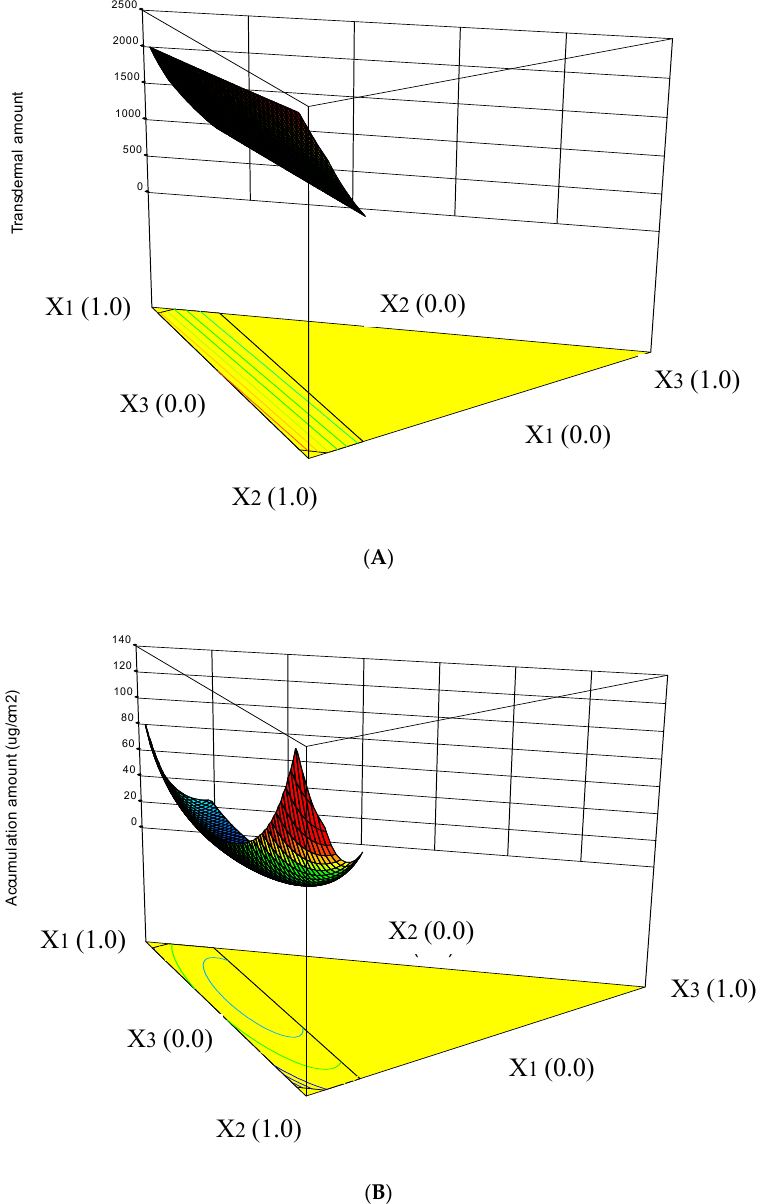
Figure 2. Three dimensional response surface diagrams for the influence of formulation variables on the transdermal amount ( A ) and accumulation amount in tissue ( B ).